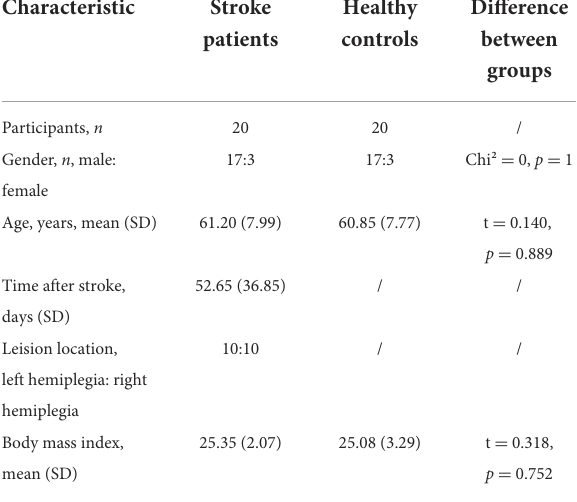
TABLE 1 Demographic characteristics of our cohort.